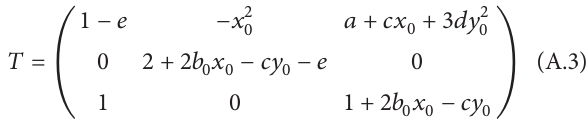
where 𝑝(𝑏 0 ) = 2𝑏𝑥 0 − 𝑐𝑦 0 − 𝑒 , 𝑞(𝑏 0 ) = −(2𝑏𝑒 + 𝑐)𝑥 0 − 3𝑑𝑦 2 0 + − 𝑎 𝑐𝑒𝑦 0